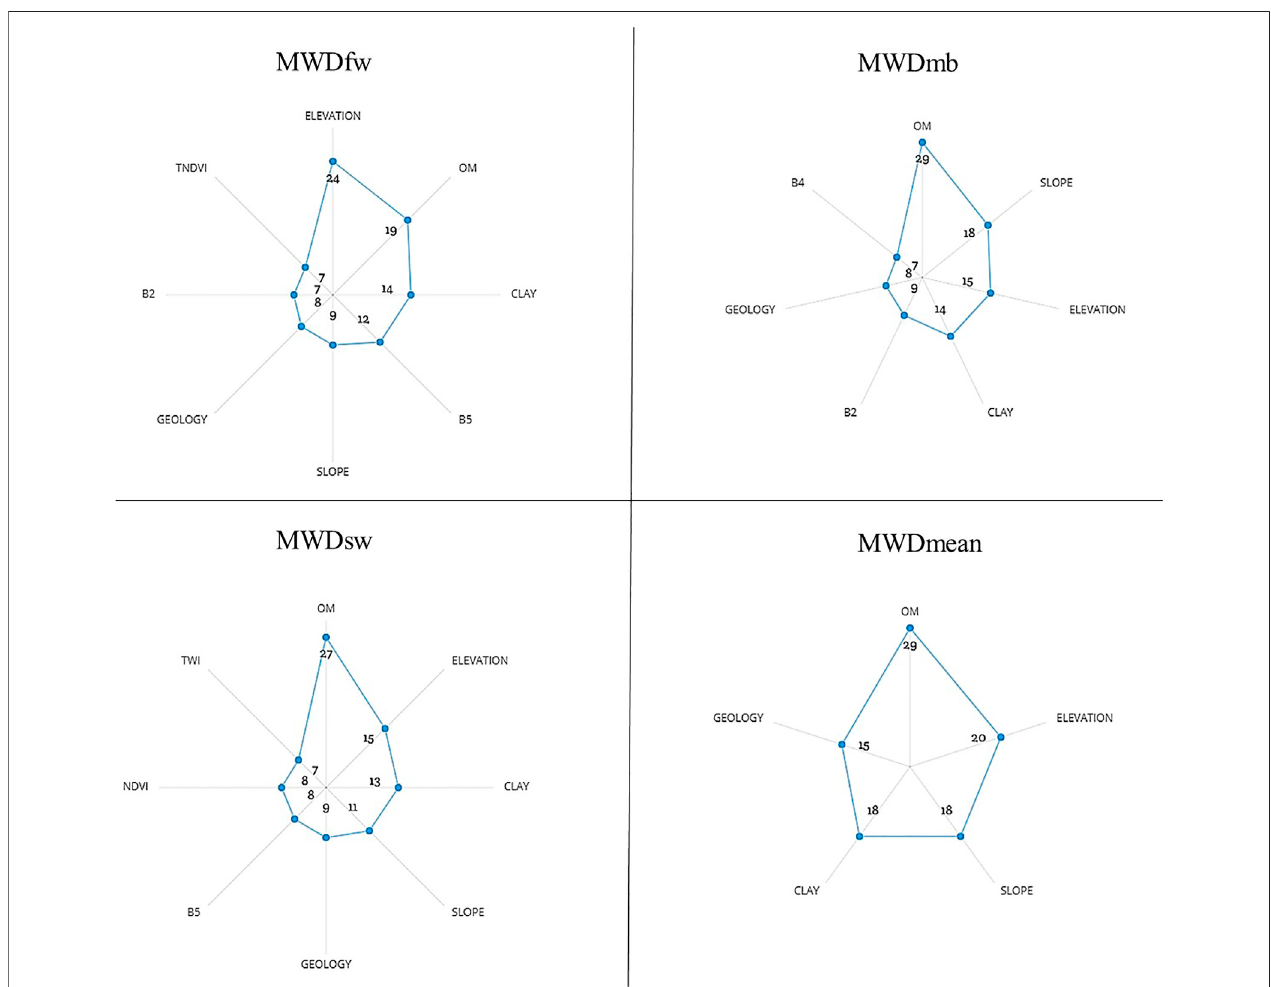
FIGURE 7 | The relative importance of different variables.